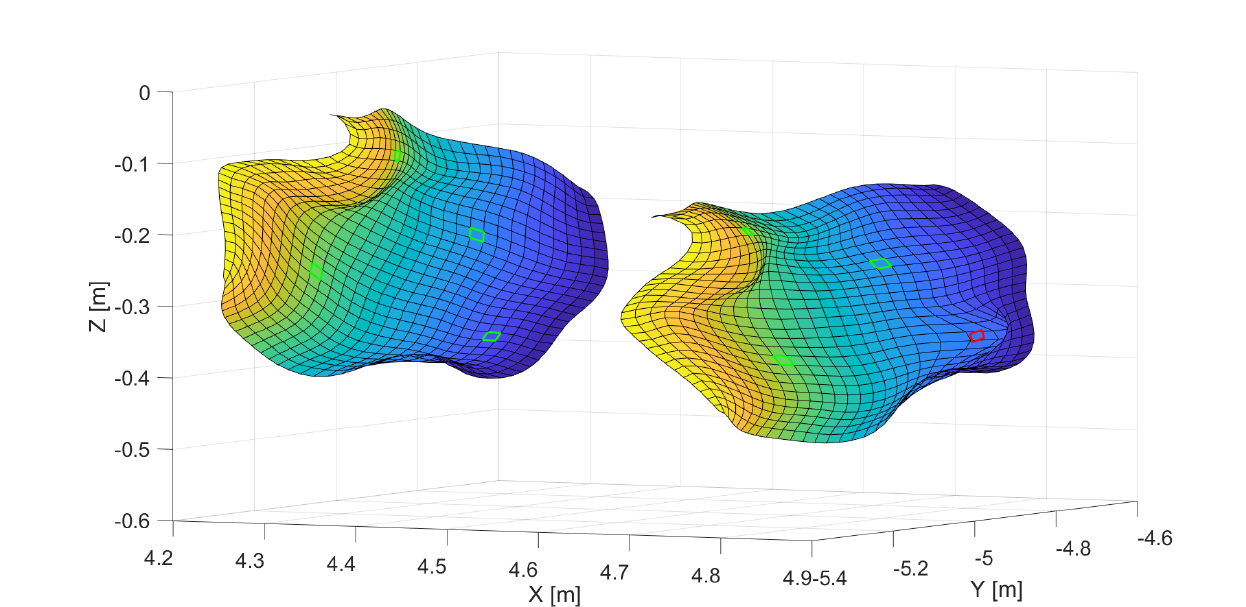
Figure 2. Rigid body movement of a B-spline surface with superimposed distortion (left surface: epoch 1, right surface: epoch 2): surface parameters in the non-distorted regions are unaffected by the distortion.